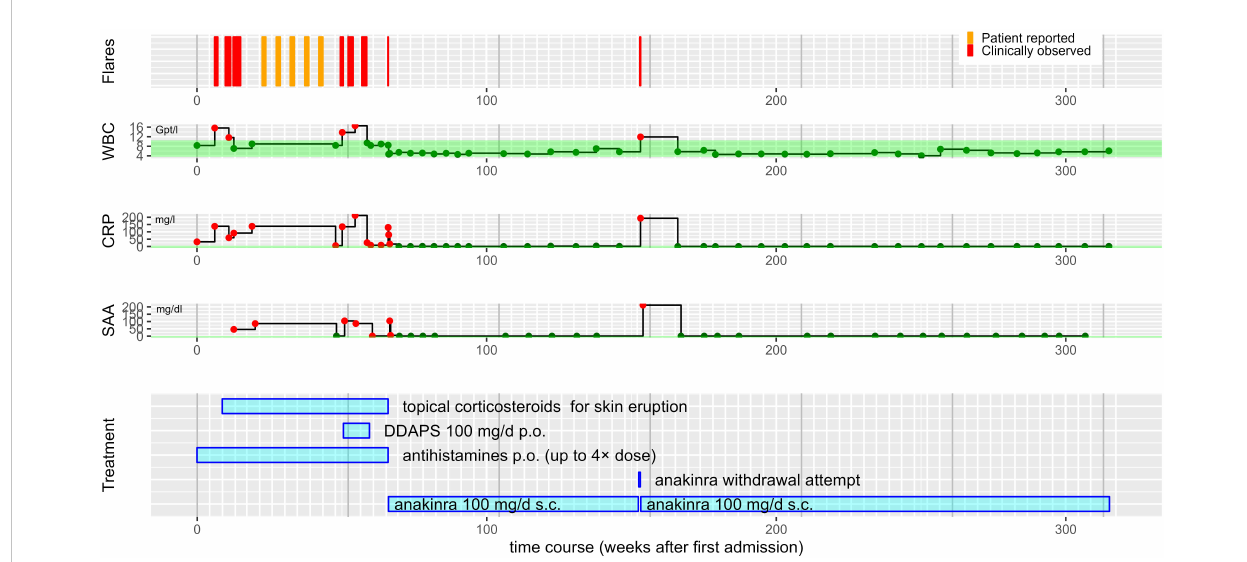
FIGURE 2 Overview of the patient ’ s disease course. Step plots of laboratory parameters over time aligned with bar chart of treatment modalities. With the exception of an immediate relapse during a single anakinra withdrawal attempt, the patient has remained free of in fl ammatory episodes for a follow period of about 250 weeks (~5 years) now. Different antihistamines including cetirizine 10 mg p.o were given up to 4x standard dose. Topical corticosteroids included methylprednisolone and clobetasol. WBC, white blood cell counts, in 1/nl. CRP, C-reactive protein concentration in mg/l. SAA, serum amyloid A concentration in mg/dl. The reference ranges are shaded in green. Red dots indicate values outside the reference range, dark green dots values within. The white vertical grid lines indicate months, the grey vertical grid lines